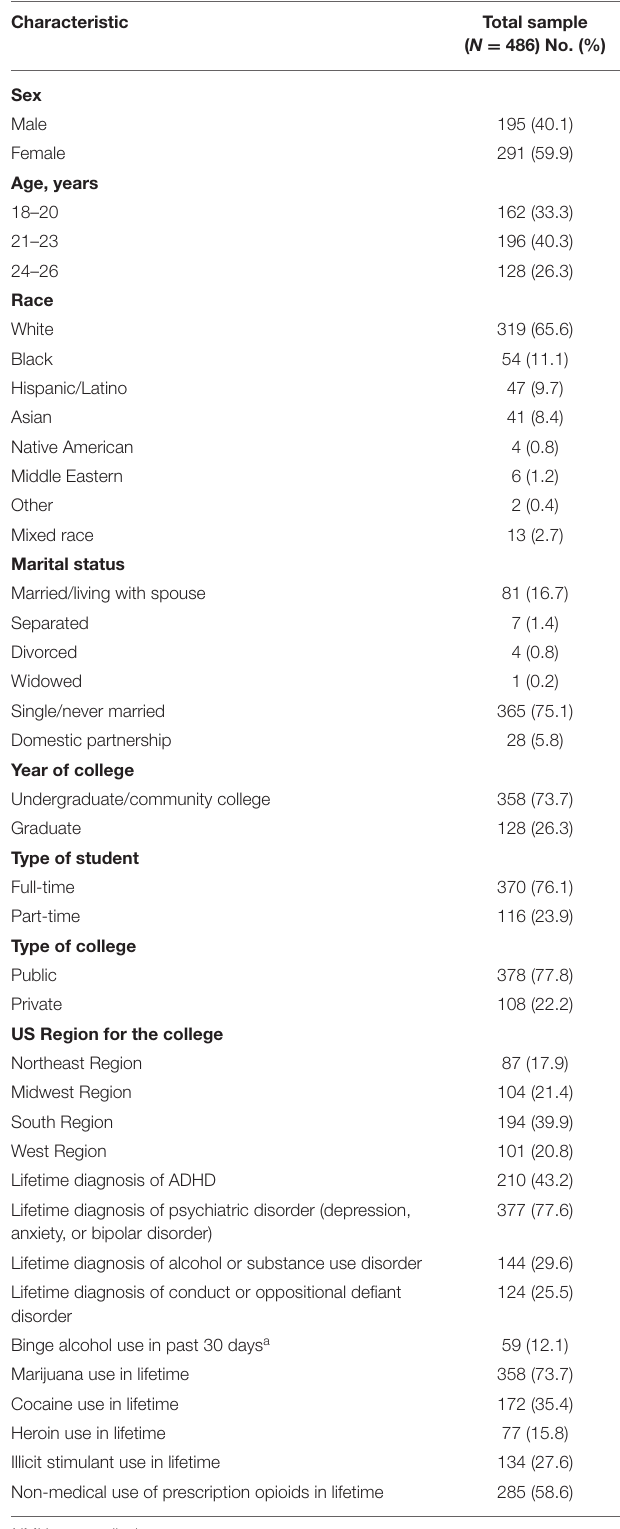
TABLE 1 | Characteristics of college students by lifetime non-medical use of prescription stimulants.